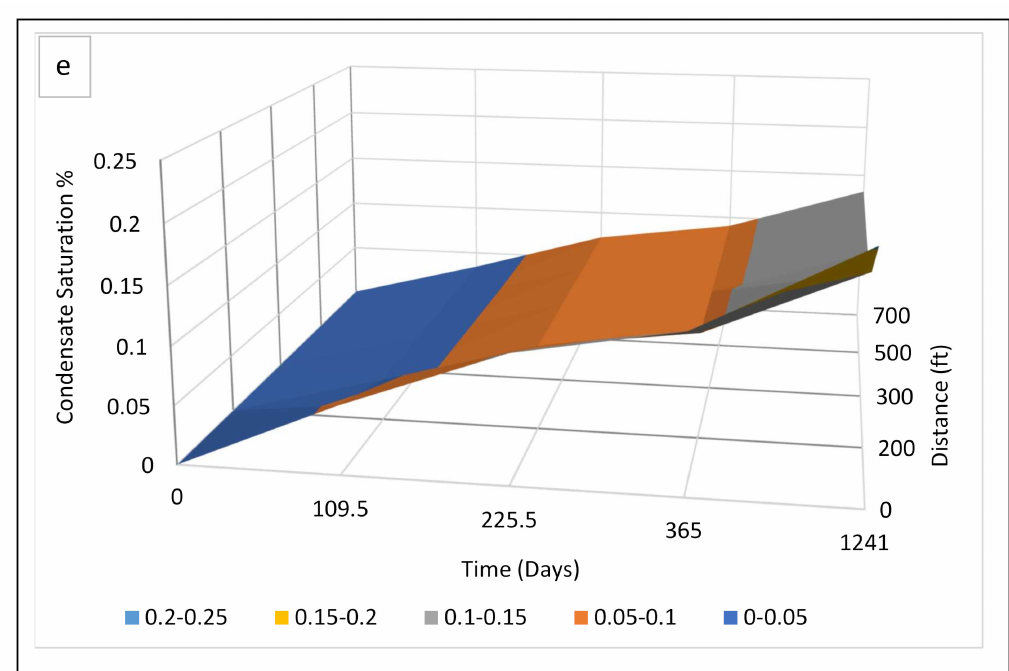
Figure 15. 3D plots for reservoirs in global analysis with values of permeability of: ( a ) 1 mD; ( b ) 5 mD;